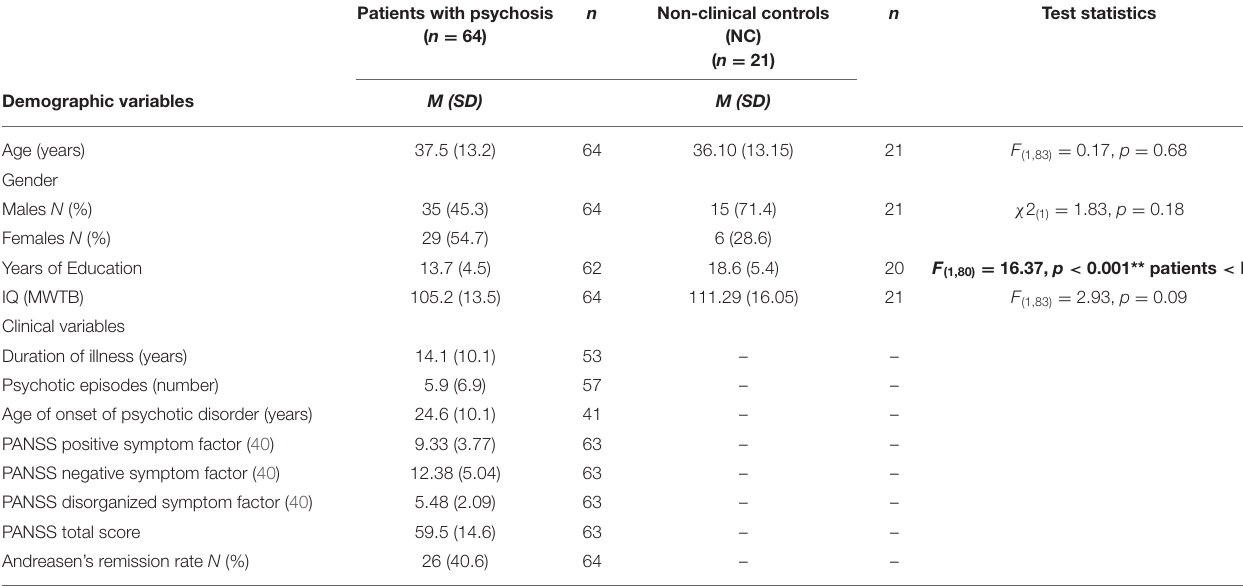
TABLE 1 | Sociodemographic and clinical characteristics of patients with psychosis and non-clinical controls. Patients with psychosis ( n = 64)